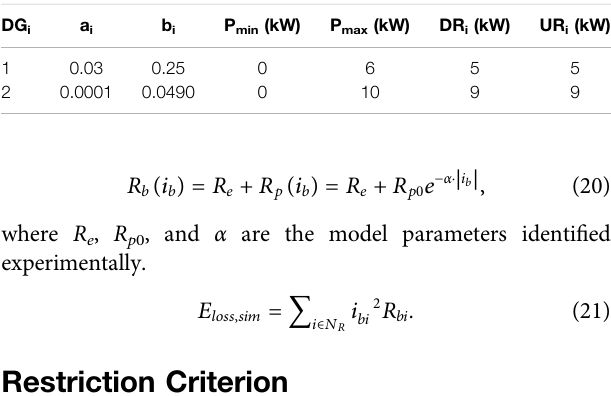
TABLE 2 | Diesel generator speci fi